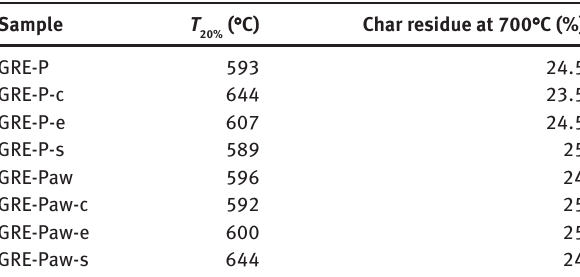
Table 4: Thermogravimetric analysis results for the GRE-P and GPE-Paw samples.